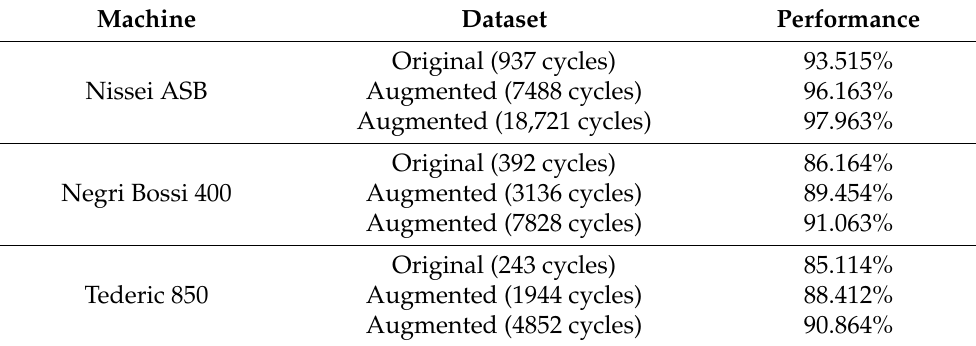
Table 3. Performance of the classifiers with and without Data Augmentation (Nissei ASB, NB400 e